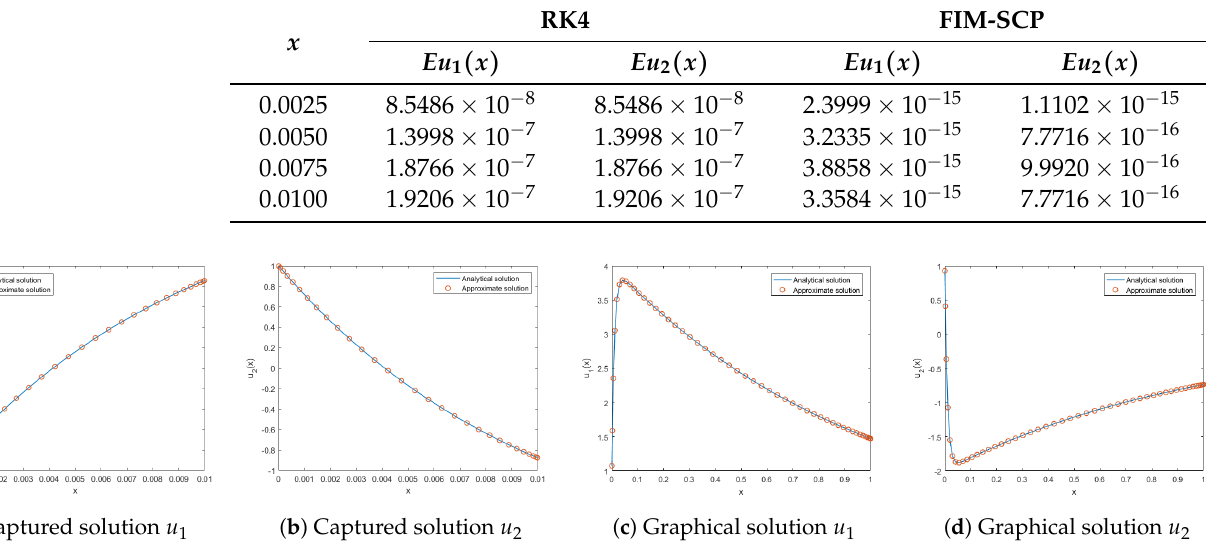
Figure 4. The graph of the approximate and exact solutions in Example